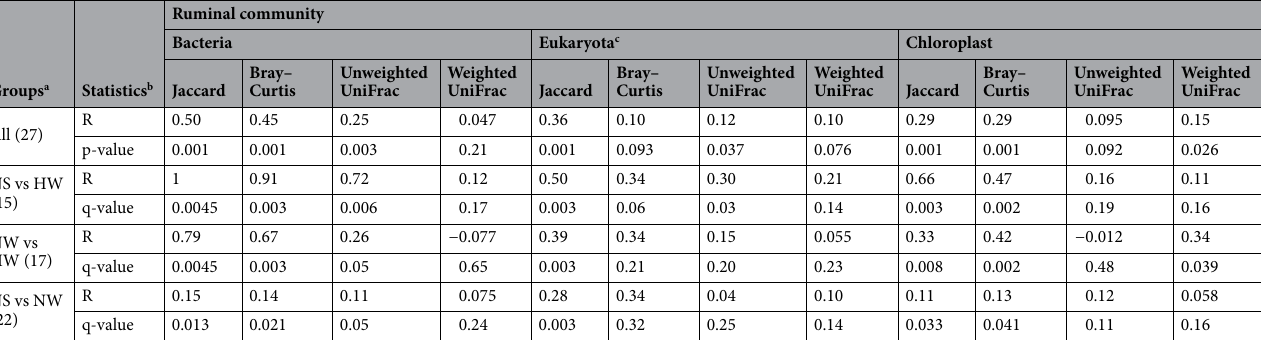
Table 2. Statistical results of beta diversity metrics in the ruminal bacterial and chloroplast composition summarized by season and location. a () Number of samples. NW, Nagano winter; NS, Nagano spring; HW, Hokkaido winter. b ANOSIM, Number of permutations = 999. c Mitochondria and chloroplast taxa were excluded.